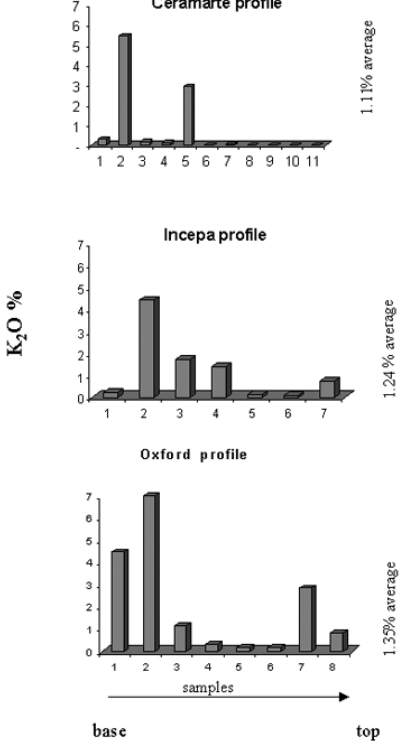
Fig. 4 – K 2 O content used as a measure of the degree of the alteration of the primary minerals in the